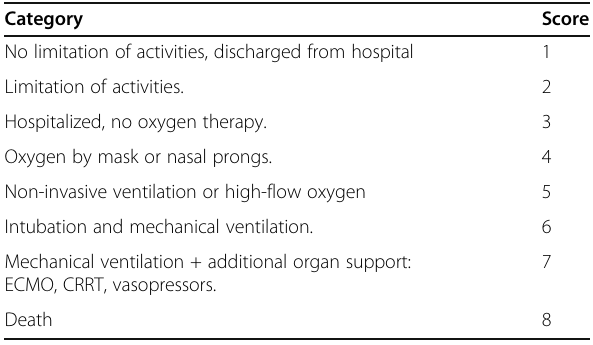
Table 1 SENTADO-COVID study seven-category ordinal scale for clinical